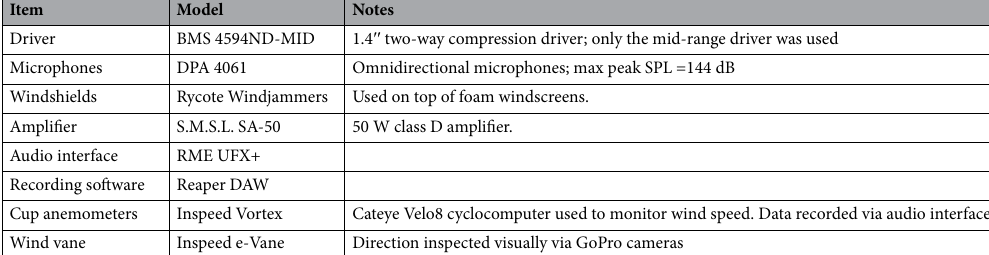
Table 1. Summary of the equipment used in the